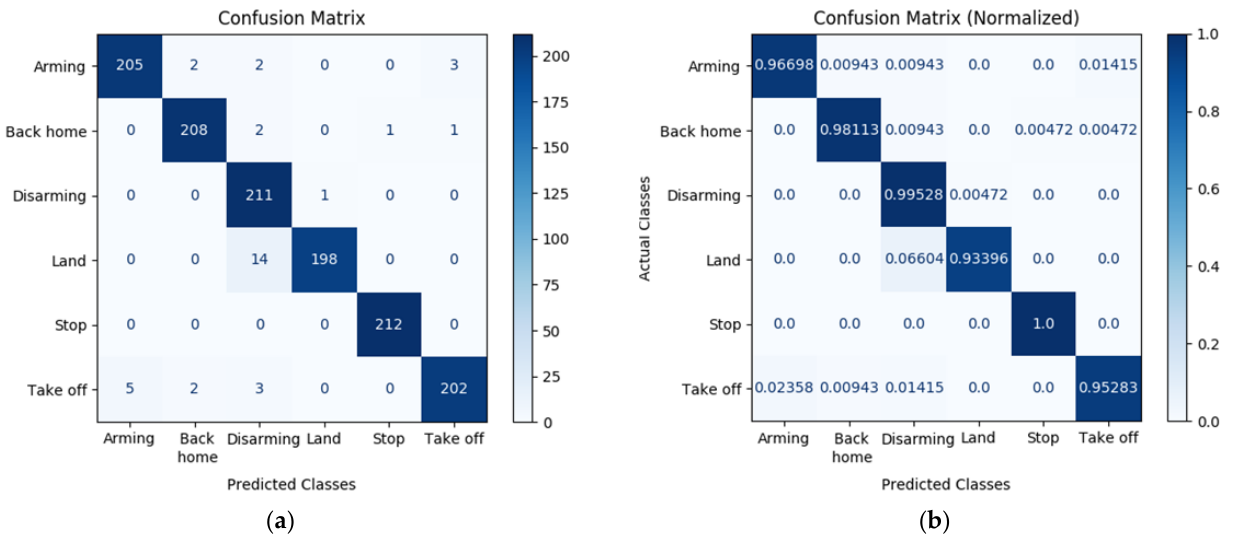
Figure 12. Confusion matrix for trained YOLOv4 model for test set. ( a ) Confusion matrix without normalization.; ( b ) Normalized confusion matrix.